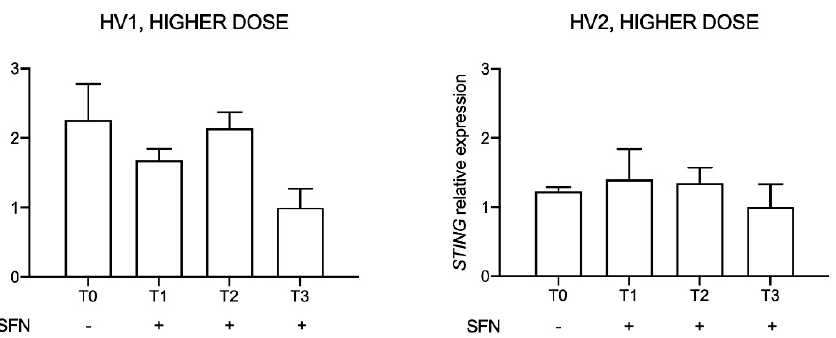
Figure 8. STING expression in two healthy volunteers (HV1, HV2) after sulforaphane (SFN) supplement administration at 90 mg/die for three days. Data are reported evaluating 2 − ∆∆ Ct values considering the last day of supplement consumption (T3) as calibrator and using HPRT1 and G6DP housekeeping genes as reference.